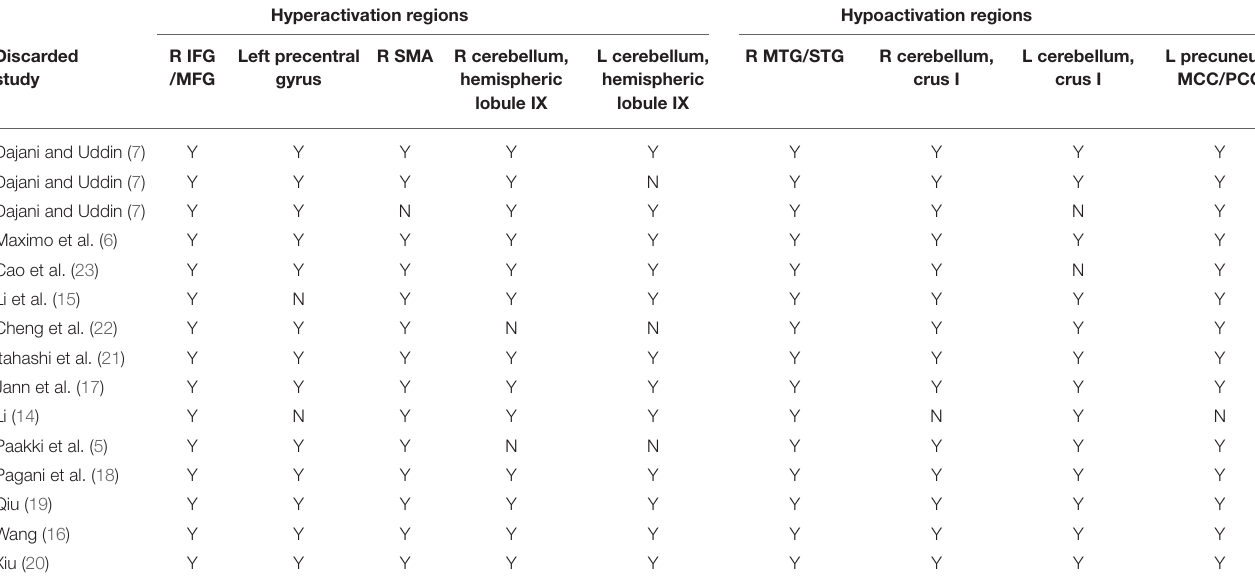
TABLE 3 | Sensitivity analyses of studies in the pooled meta-analysis of ASD vs. healthy controls. Hyperactivation